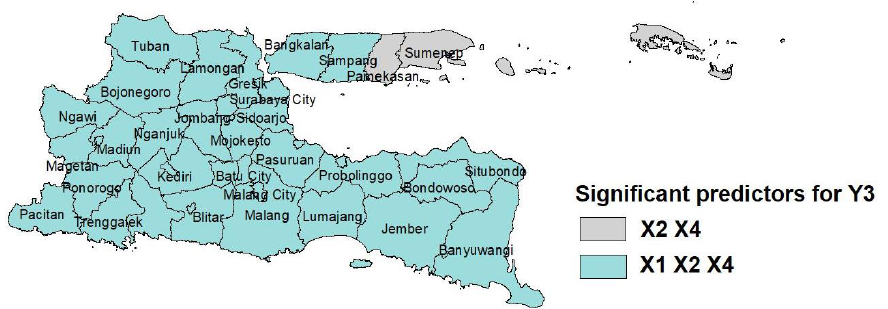
Figure 7. Regional group based on factors that influence the number of maternal deaths in East Java in 2019.